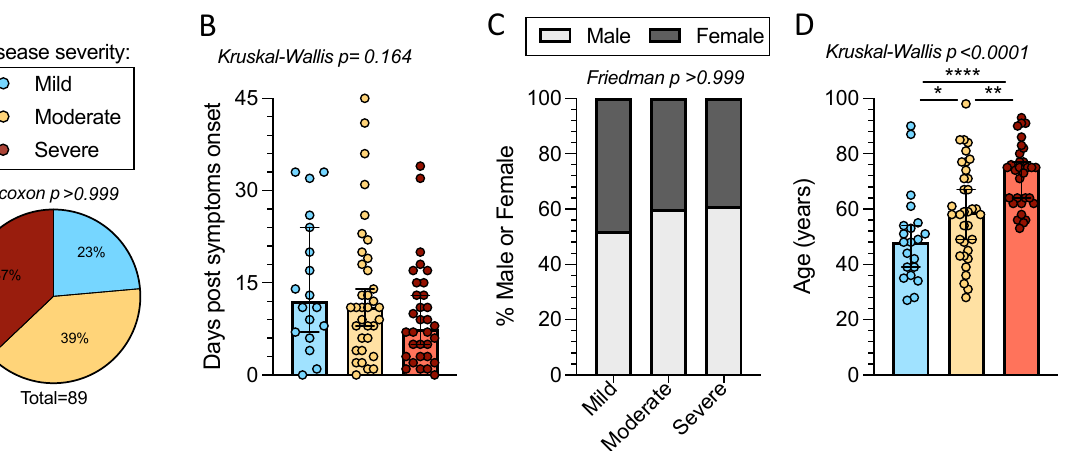
Figure 1. Time from symptom onset, sex, and age distributions of mild, moderate, and severe acute COVID-19 subjects. Peripheral blood mononuclear cells (PBMCs) were collected from 89 acute COVID-19 donors. ( A ) COVID-19 disease severity composition; mild ( n = 21, blue), moderate ( n = 35, yellow), and severe ( n = 33, red). The p -value listed above the pie chart was calculated by a one sample Wilcoxon t test. ( B ) Days post-symptom onset (PSO) for the different disease severities. Bars represent the median with 95% confidence intervals. p -value is calculated by Kruskal–Wallis t test. ( C ) Percentage of female (dark grey) and male (white) subjects by disease severity. p -value is calculated by Friedman one-way ANOVA. ( D ) Age composition for each disease severity category. Bars represent the median and 95% confidence interval and the Kruskal–Wallis t test p -value is listed above the graph. When the Kruskal–Wallis t test was significant, Mann–Whitney U tests were applied between disease severities. * p < 0.05, ** p < 0.01, **** p < 0.0001.